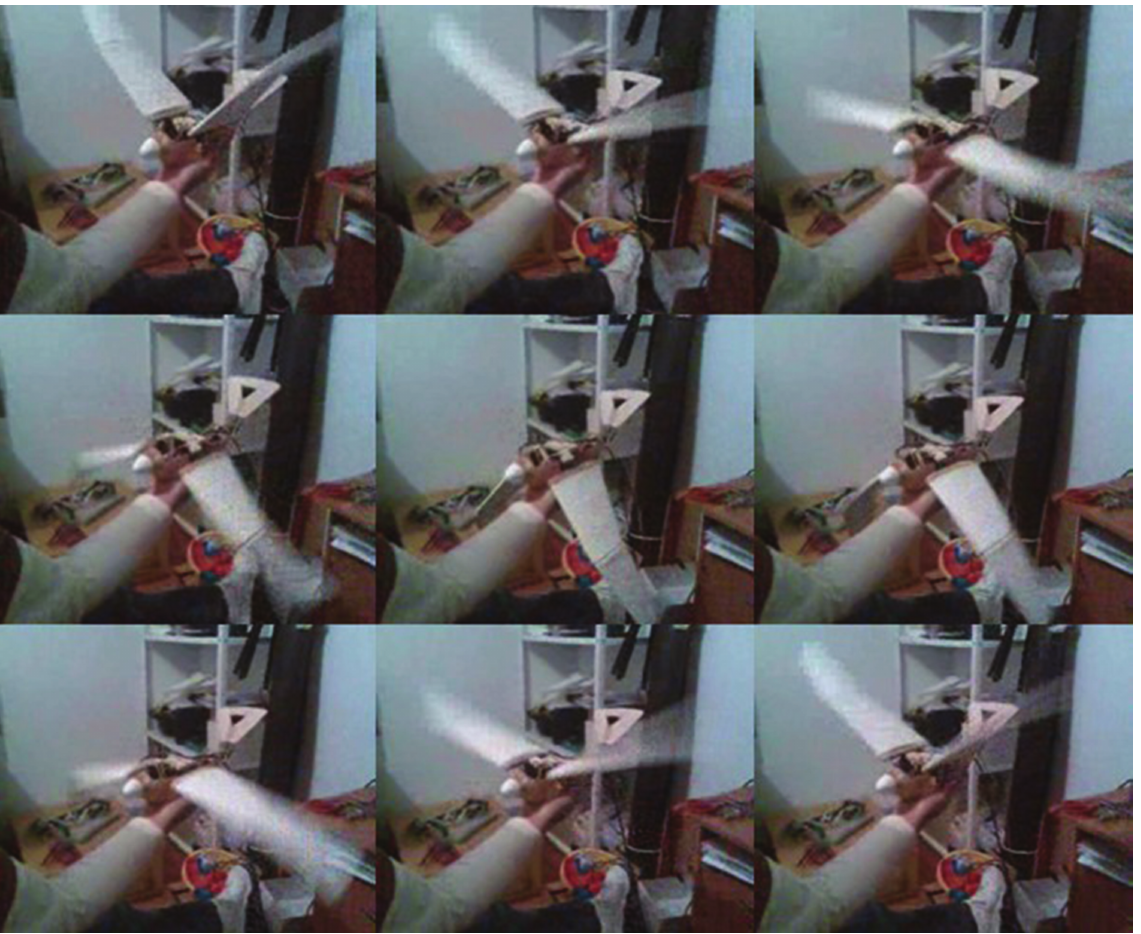
Figure 1: Sequence of images illustrating the wings-beat of the robotic bird